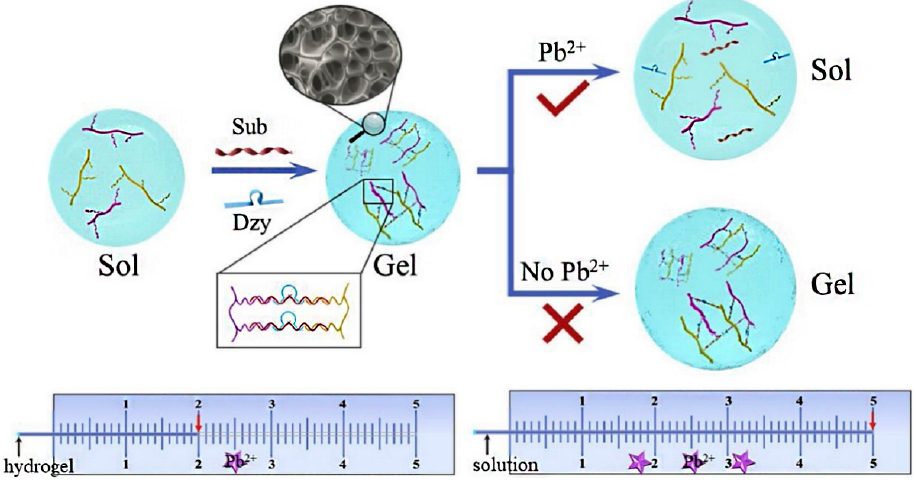
Figure 12. Schematic illustration of DNA hydrogels in capillary for the detection of Pb 2+ . Reproduced with permission from Chao Jiang, Sensors and Actuators B: Chemical; published by Elsevier, 2020.